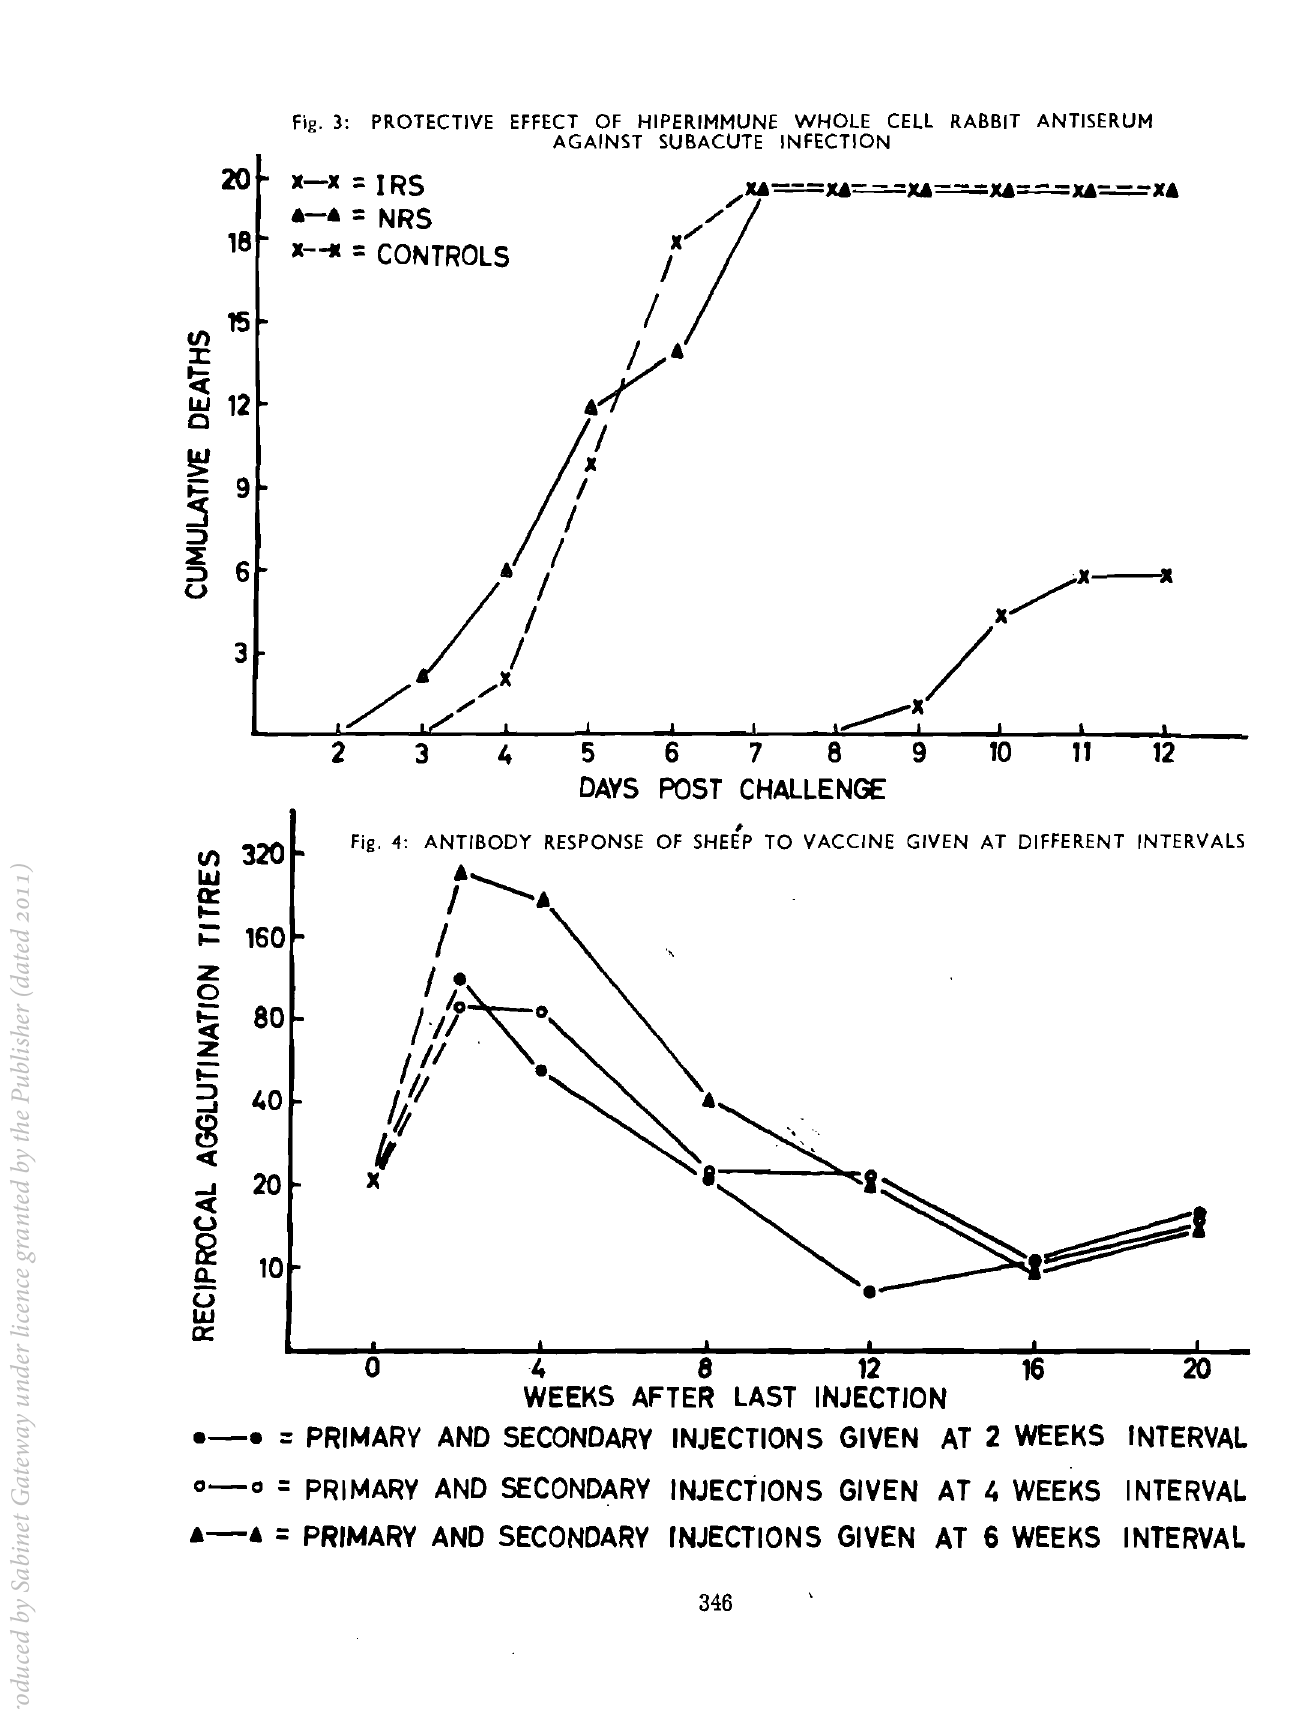
Fig. 3: PROTECTIVE EFFECT OF HIPERIMMUNE WHOLE CELL RABBIT ANTISERUM AGAINST SUBACUTE INFECTION = x-x IRS = NRS A-A